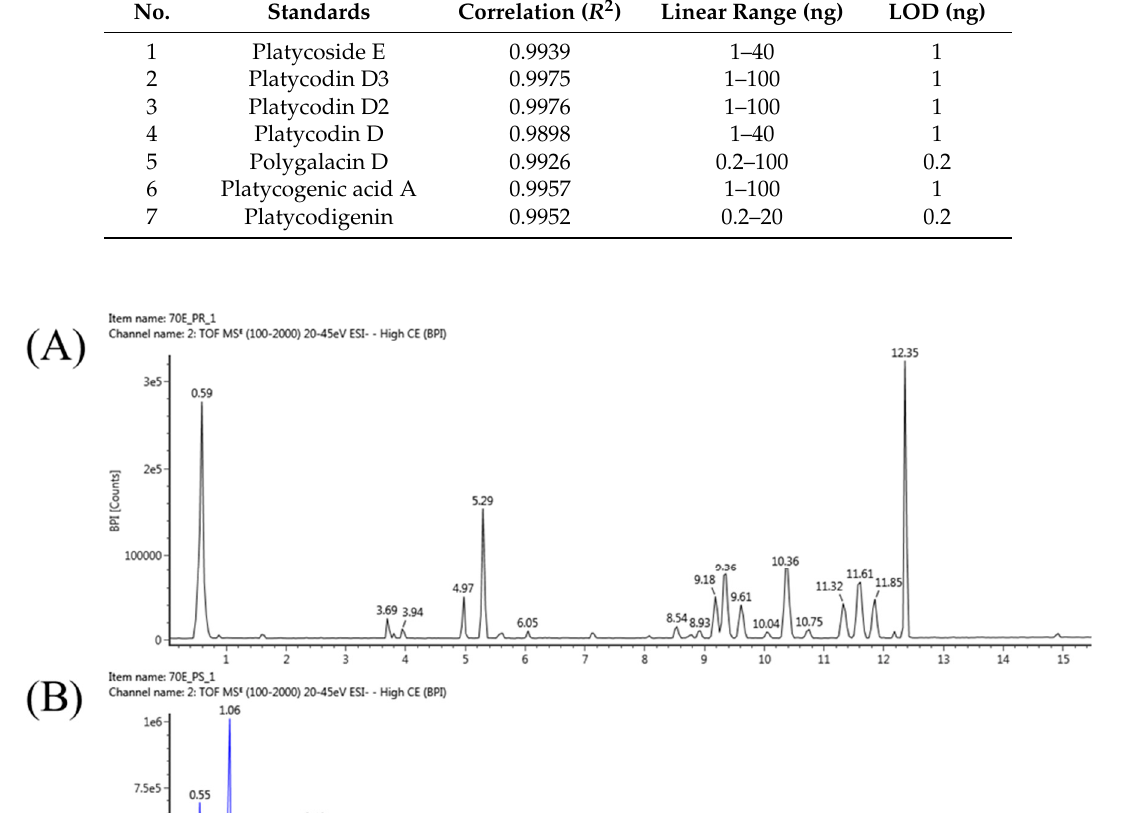
Table 2. The linearity range, correlation ( R 2 ) and LOD of seven standards by UPLC-QTOF/MS. No.